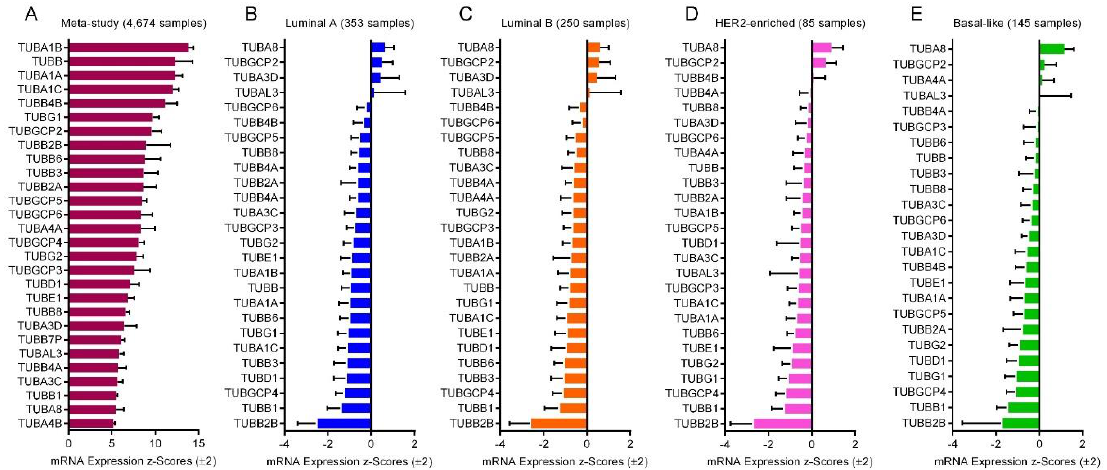
Figure 4. mRNA expression of tubulin isoforms in BC tumors. ( A ) Z-score mRNA expression (RNA- seq v2 RSEM) values of the tubulin isoforms in meta-study BC tumor samples. ( B ) Z-score mRNA expression (microarray) values of the tubulin isoforms in luminal A, ( C ) luminal B, ( D )